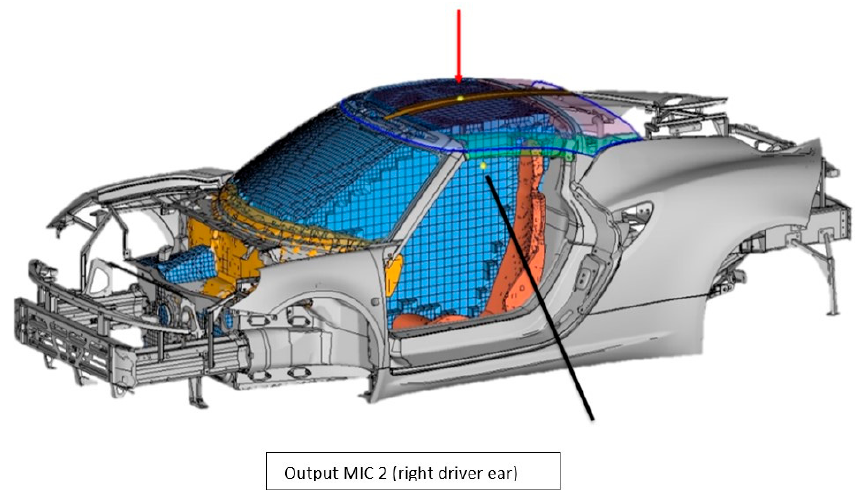
Figure 26. Hall center input where exciting the structure and measurement point for sound pressure level (MIC 2).